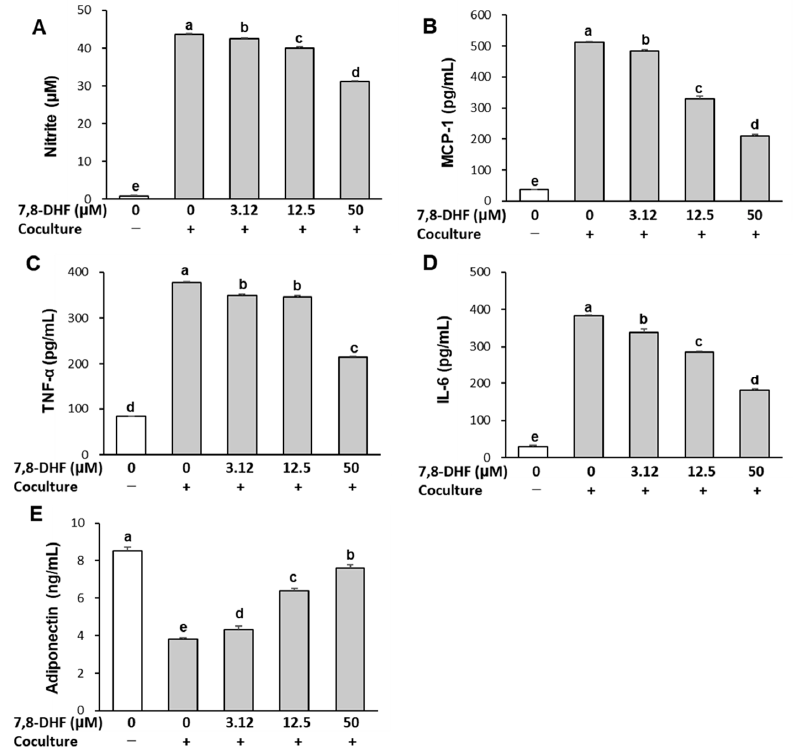
Figure 2. Effect of 7,8-DHF on inflammatory changes in coculture of adipocytes and macrophages. Hypertrophied 3T3-L1 adipocytes were cocultured with RAW 264.7 macrophages for 24 h and then treated with 7,8-DHF for 24 h in the contact system. The concentrations of NO ( A ), MCP-1 ( B ), TNF- α ( C ), IL-6 ( D ), and adiponectin ( E ) were measured in the coculture medium as described in Materials and Methods. Values are means ± SD ( n = 3) and representative of results obtained from three independent experiments. Means without the same letters are significantly different by ANOVA, followed by Duncan’s test ( p < 0.001). +: adipocytes were cocultured with macrophages, − : adipocytes and macrophages were separately cultured and mixed before the assay. 7,8-DHF, 7,8-dihydroxyflavone; NO, nitric oxide, MCP-1, monocyte chemoattractant protein-1; TNF- α , tumor necrosis factor-alpha; IL-6,